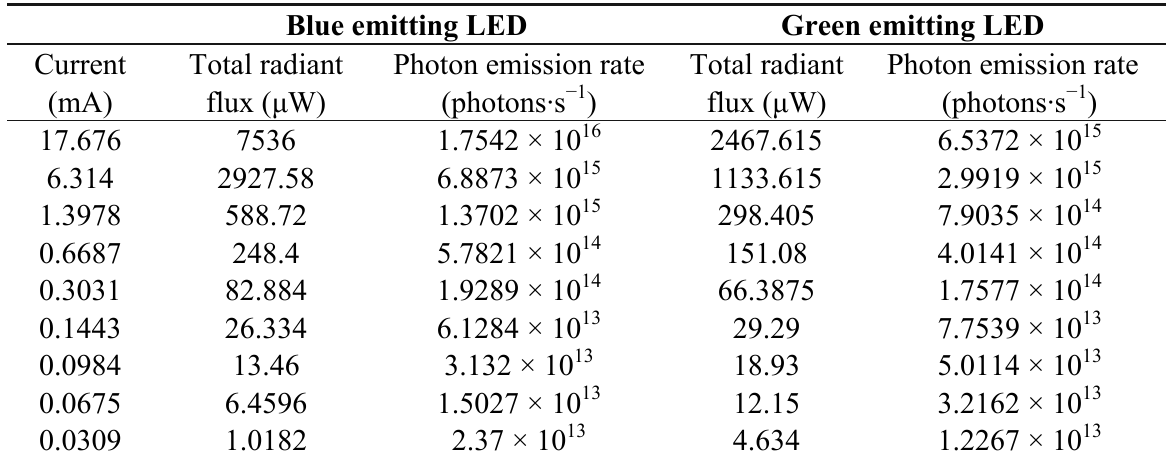
Table 2. Illumination with two LEDs: Diode current, electrical power and total photon emission rate were determined for the blue emitting LED and the green emitting